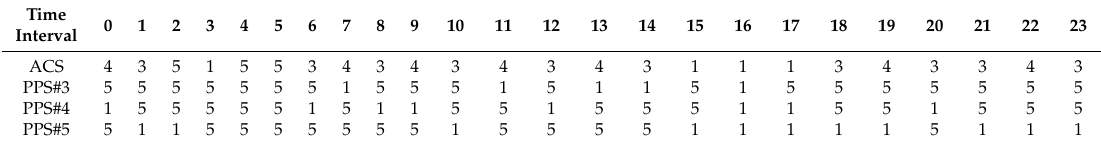
Table 6. Determined operating points for schedulable tasks (STs) during each time interval.